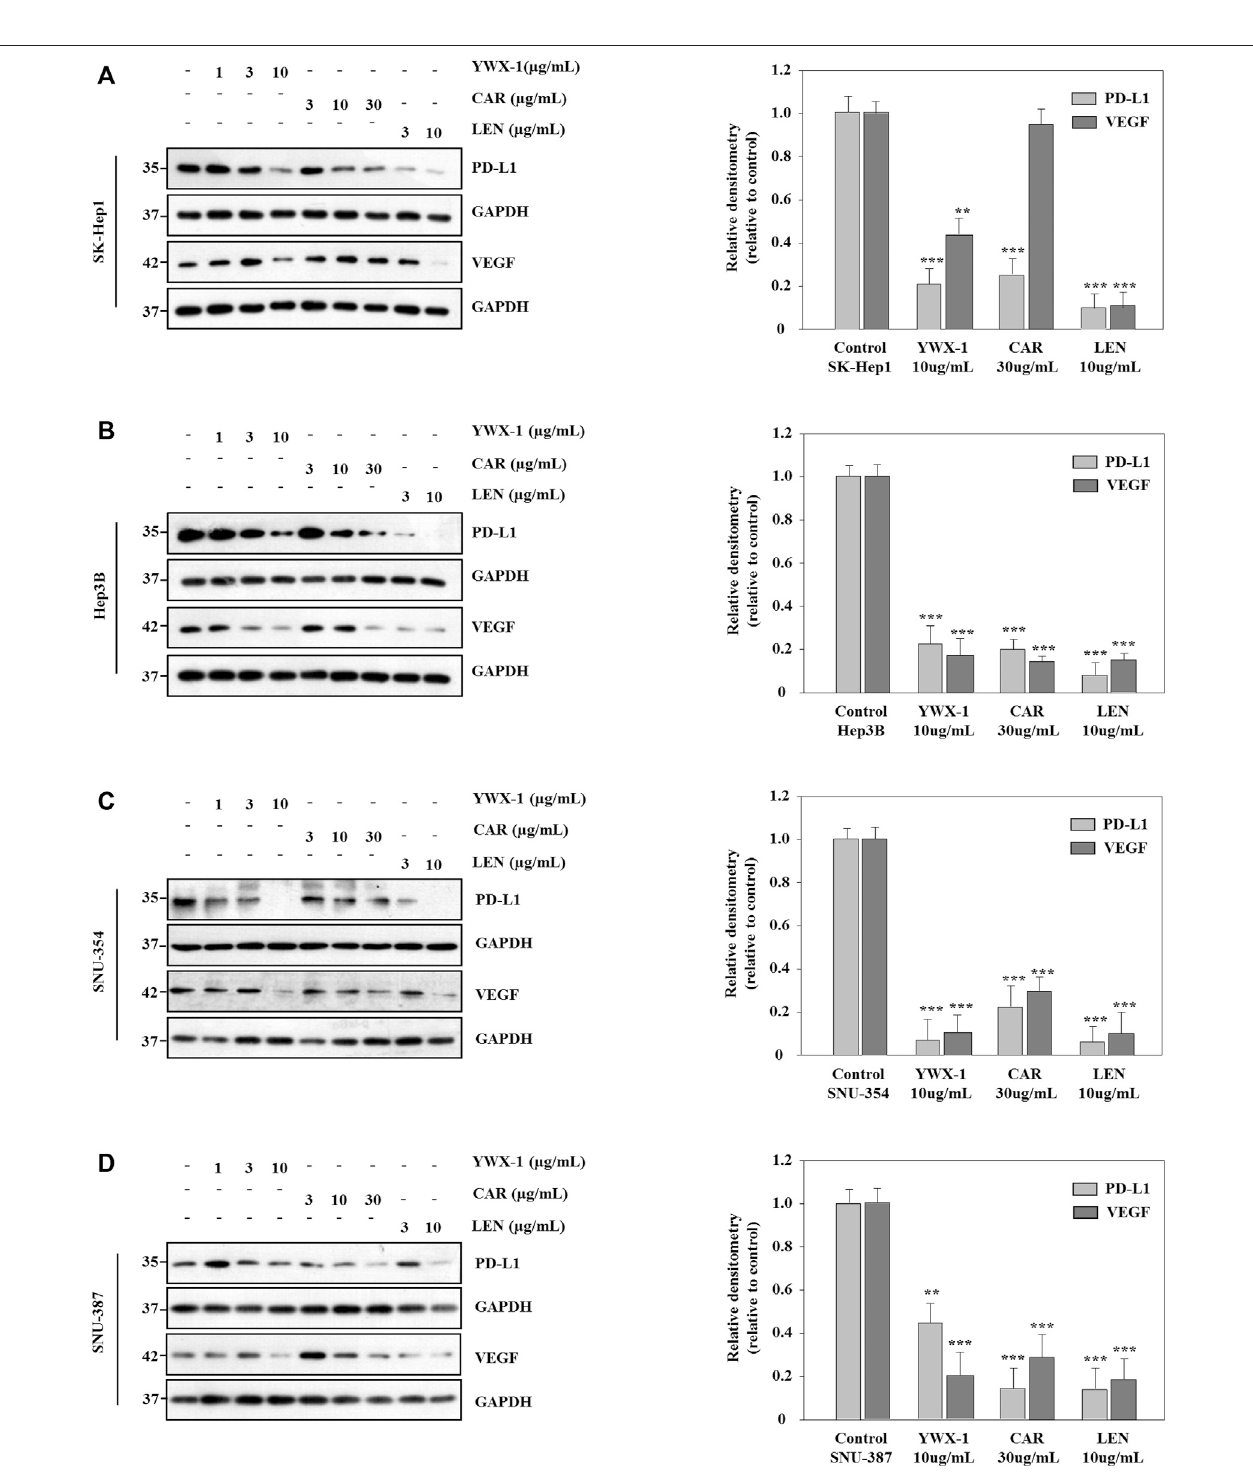
FIGURE 7 | Carrimycin (CAR) and monomeric isovalerylspiramycin I (YWX-1) inhibit the expressions of VEGF and PD-L1 protein in hepatocellular carcinoma cells. (A – D) SK-Hep1, Hep3B,SNU-354,and SNU-387cellsweretreatedwithdifferentconcentrationsofcarrimycin andmonomericisovalerylspiramycinI.Theproteinlevels ofVEGFandPD-L1wereanalyzedbywesternblotting.GAPDHlevelwasusedasaloadingcontrol.Statisticallysigni fi cantdifferencesareindicatedwhencomparedwith control group. Data represented as mean ± standard deviation of three independent experiments (n (cid:2) 3).